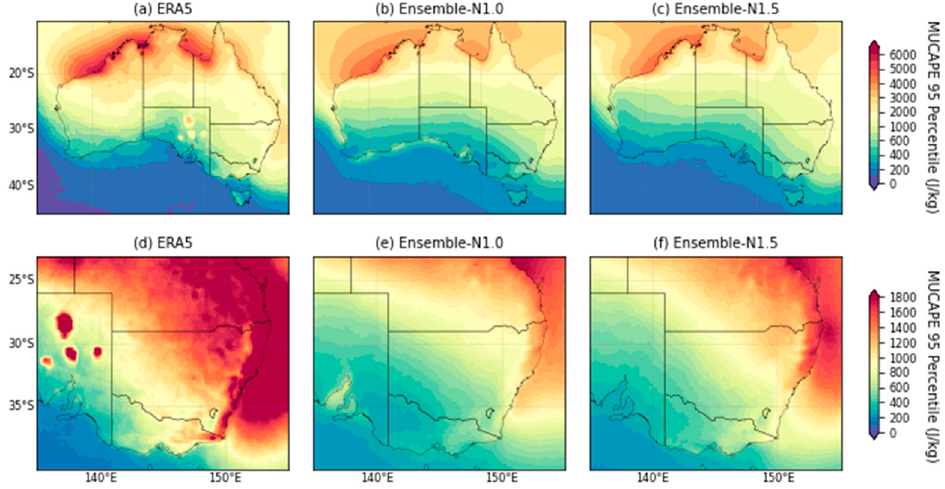
Figure 9. Percentile of 95% within the reference period 1990–2009 in MUCAPE for domain ( a – c ) d01 and ( d – f ) d02 from ( a , d ) ERA5, ( b , e ) N1.0 and ( c , f ) N1.5 during DJF. Unit: J kg − 1 .